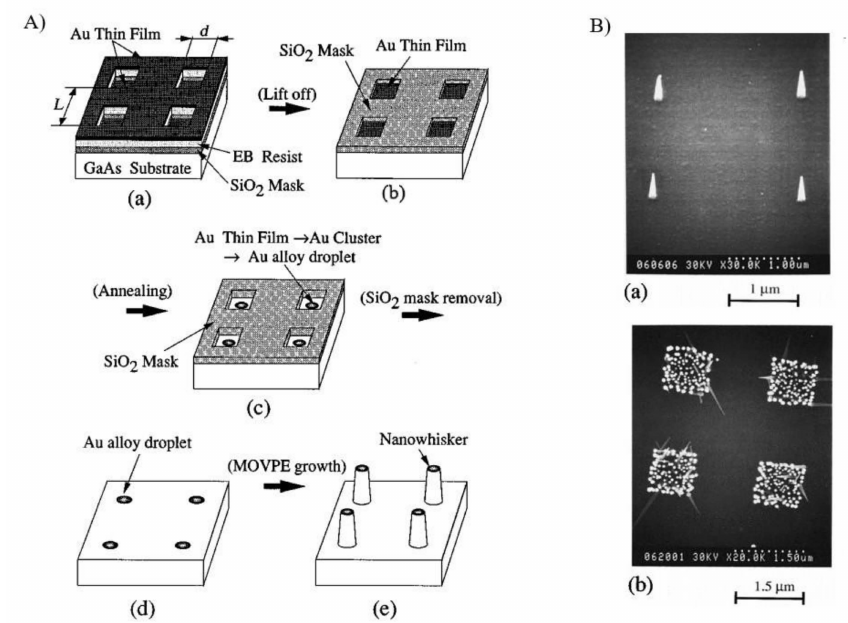
Figure 2. ( A ) Pictorial representation of the site-controlled growth method of nanowires reported in the first works on nanowire positioning (a) SiO 2 mask formation by electron-beam lithography; (b) removal of Au atoms from the masked region by the lift-off process; (c) Au alloy droplet formation by annealing; (d) removal of SiO 2 mask; (e) MOVPE growth of nanowhiskers; ( B ) scanning electron micrographs of the first nanowire positioning experiments, varying the dimension of the mask’s openings (a) individually seeded NWs, (b) growth on selected areas (reprinted with permission of Ref.